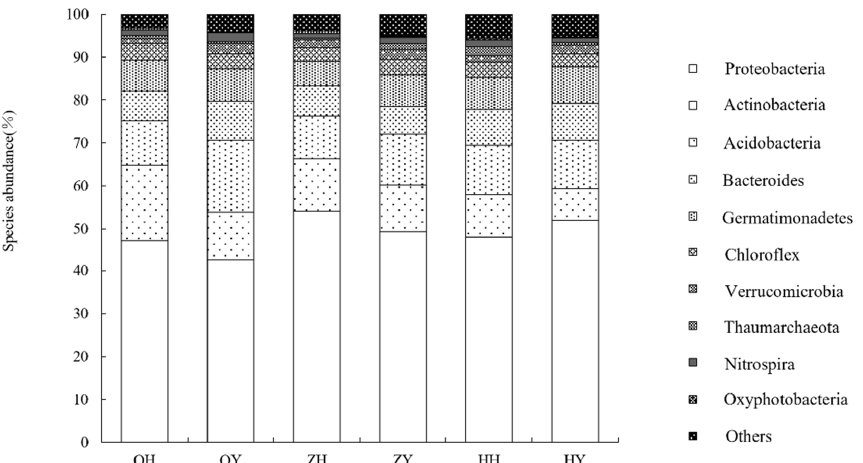
Figure 5. Relative abundance of bacterial communities in rhizosphere soil of treated with carbon- based fertilizer and chemical fertilizers. Note: QH-Chemical fertilizer treatment on 8 July; QY-Carbon- based fertilizer treatment on 8 July; ZH-Chemical fertilizer treatment on 16 August; ZY-Carbon-based fertilizer treatment on 16 August; HH-Chemical fertilizer treatment on 26 September; HY-Carbon- based fertilizer treatment on 26 September.